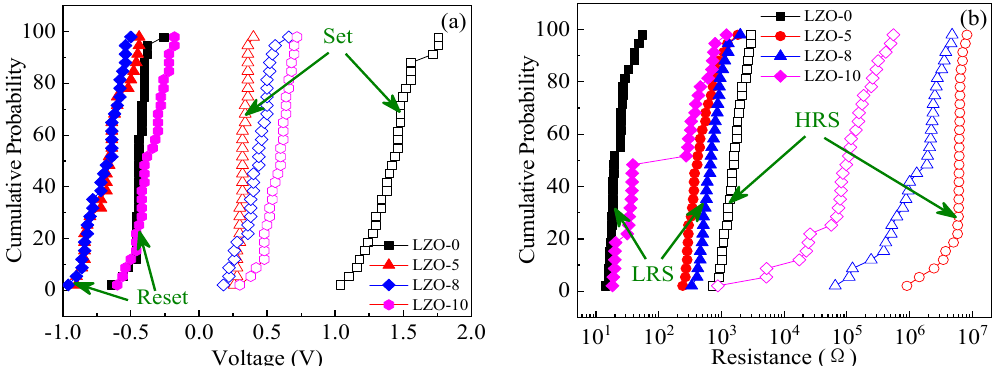
Figure 6. The statistical distributions of resistive switching parameters for the RRAM devices: ( a ) set and reset voltages; ( b ) high-resistance state (HRS) and low-resistance state (LRS) resistances.